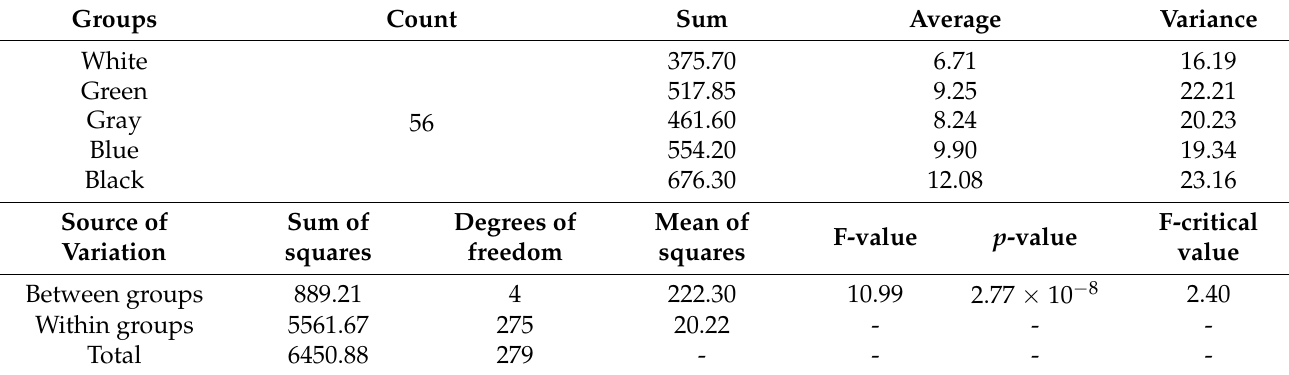
Table 8. ANOVA test for the comparison of indoor temperature differences between colored roofs.